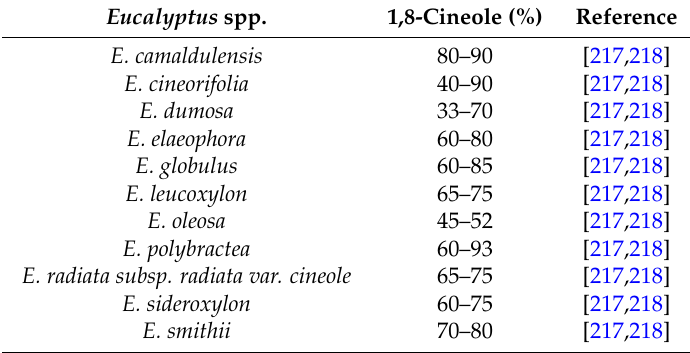
Table 7. Eucalyptus species typically used to produce medicinal essential